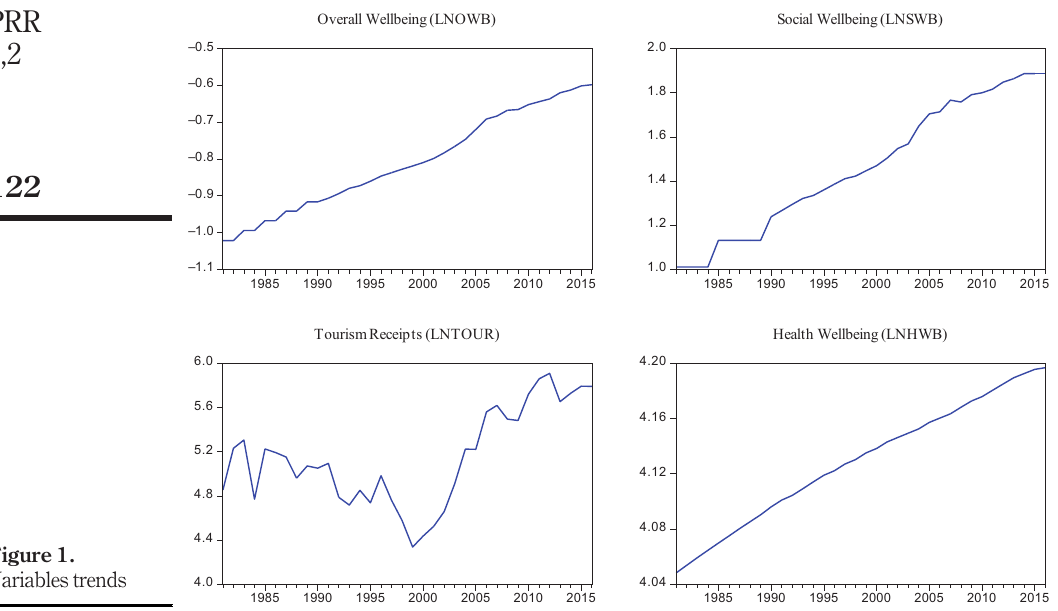
Figure 1. Variables